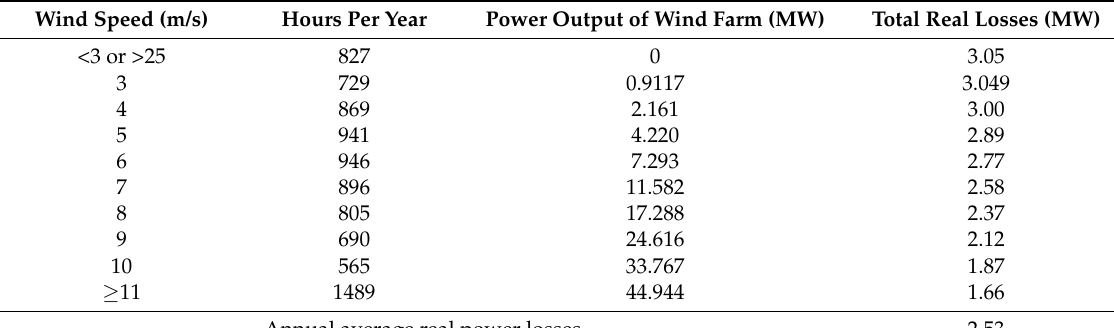
Table 2. Total real power losses for bus 5 with the wind farm.